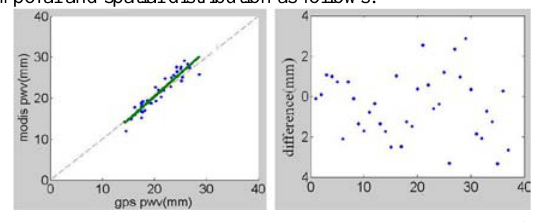
Figure5. temporal and spatial distribution comparison of MERIS PWV and GPS